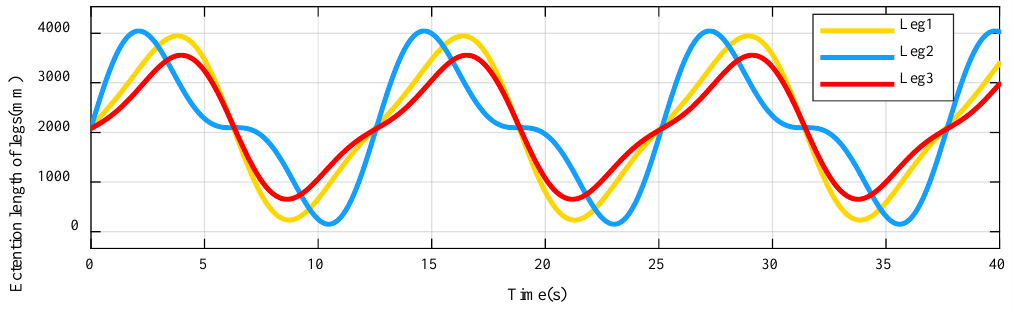
Figure 26. Leg elongation extent of the original wave compensation platform.